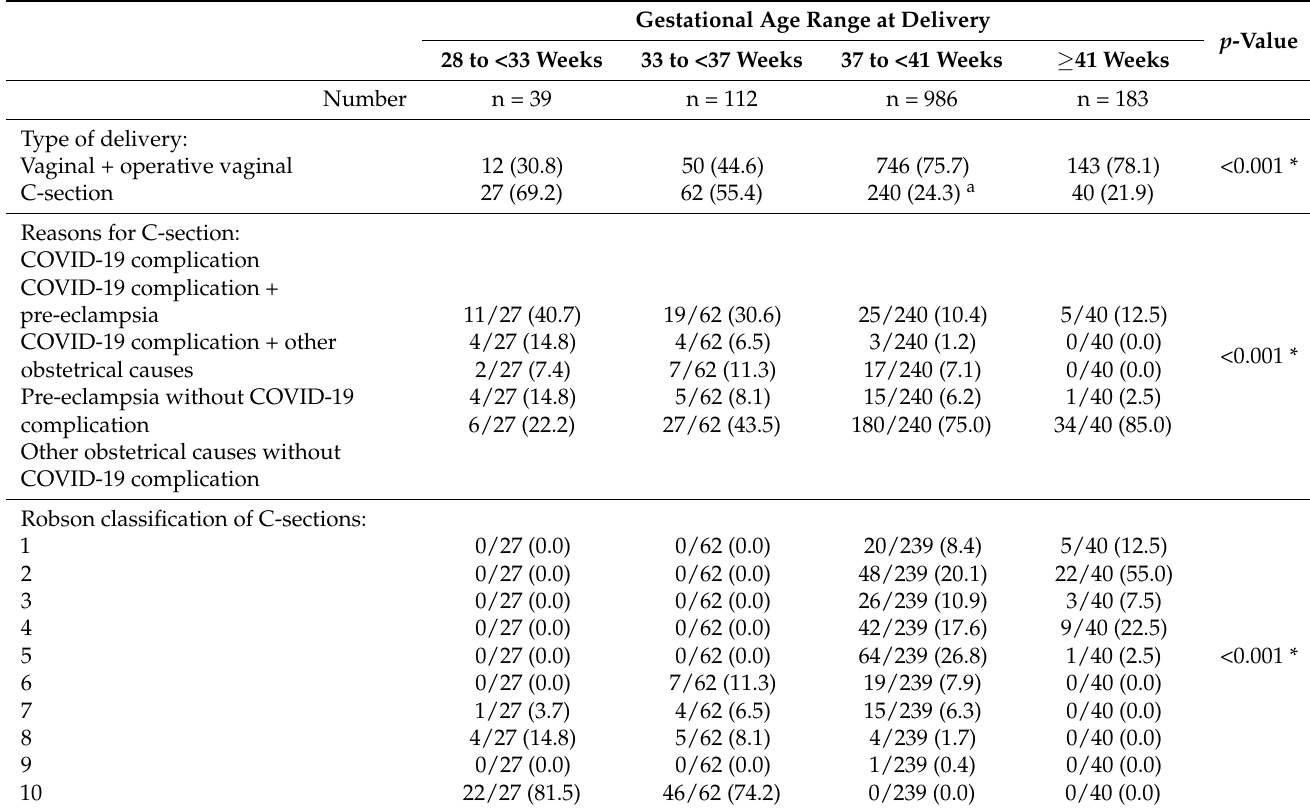
Table 4. Description of C-sections by gestational age range at delivery in mothers that were infected in the 3rd trimester of gestation (n =